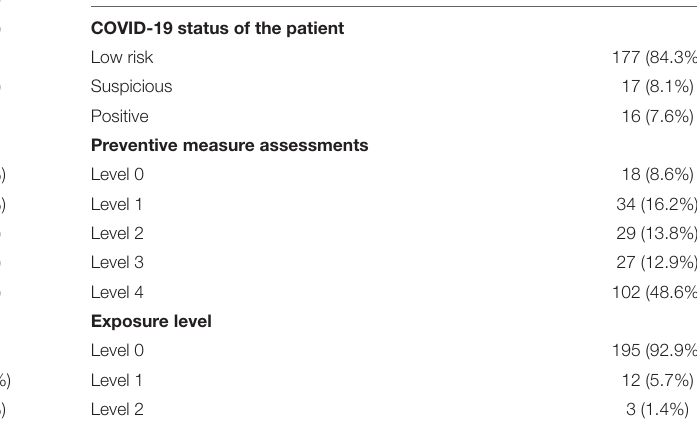
TABLE 2 | Coronavirus disease 2019 (COVID-19) status, preventive measures, and exposure levels of 210